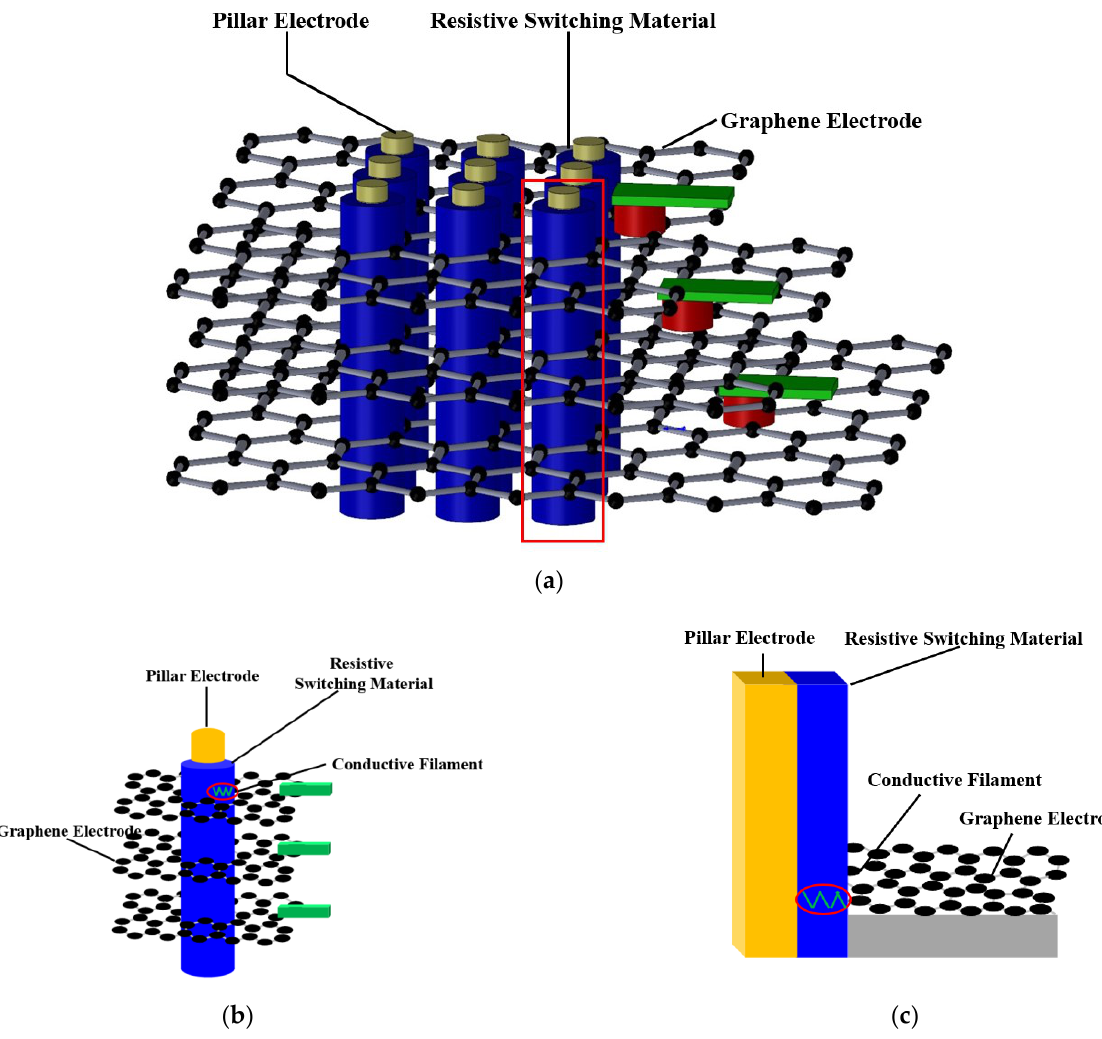
Figure 1. ( a ) Schematic of GE-RRAM array, ( b ) details of GE-RRAM cells in one pillar electrode, and ( c ) cross section of a single GE-RRAM cell through the central axis of the pillar electrode.